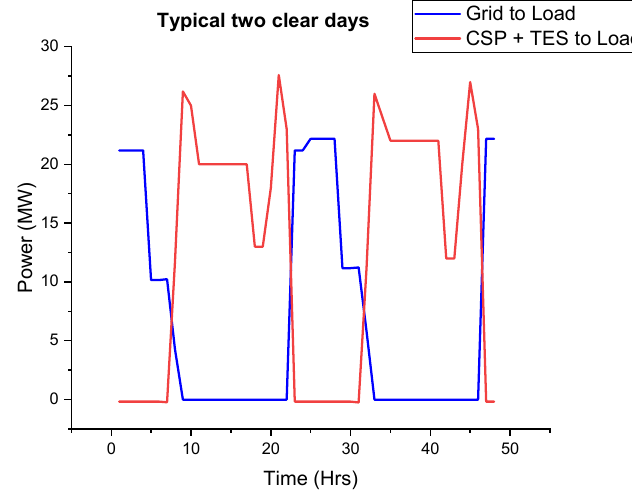
Figure 28. Two typical consecutive days with good CSP production.